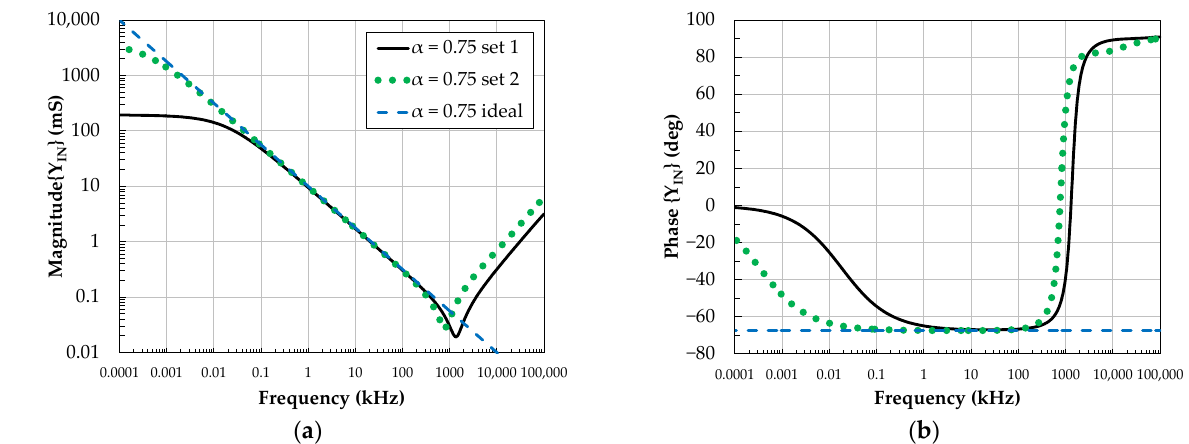
Figure 11. Simulated magnitude ( a ) and phase ( b ) characteristics of gyrator input admittance for α = 0.5.